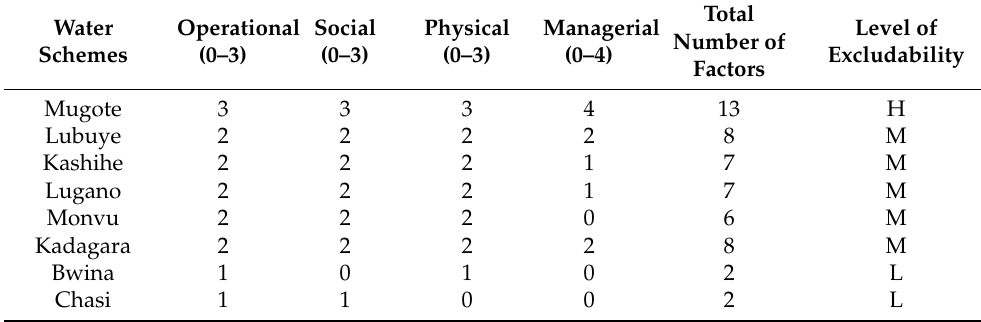
Table 3. Factors of excludability quantified for each water scheme.